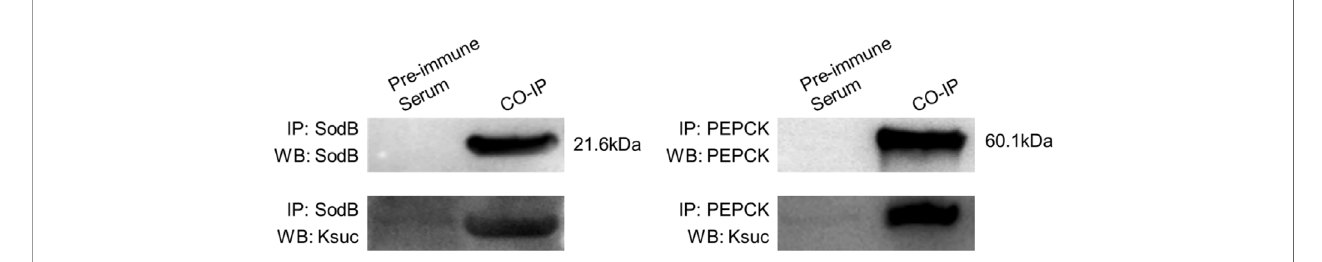
FIGURE 5 | Validation of SodB and PEPCK lysine-succinylated proteins in V. alginolyticus using Co-Immunoprecipitation and Western blotting. SodB and PEPCK proteins were enriched by Co-IP with speci fi c antibodies, followed by Western blotting with SodB and PEPCK proteins speci fi c antibodies (above), and Western blotting with anti-lysine succinylation